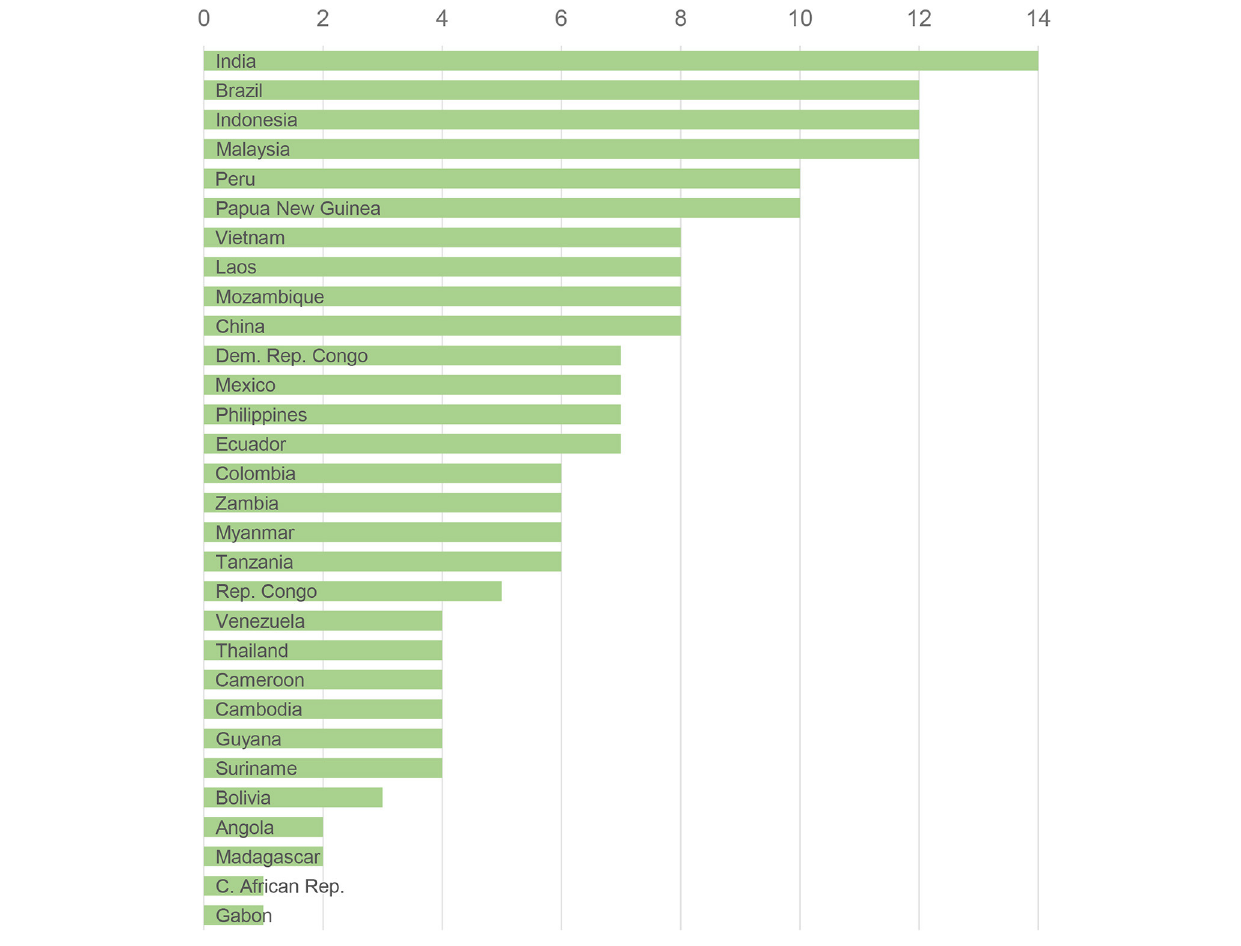
FIGURE 1 | Number of authorities (out of 14) held by second-tier governments in each country.